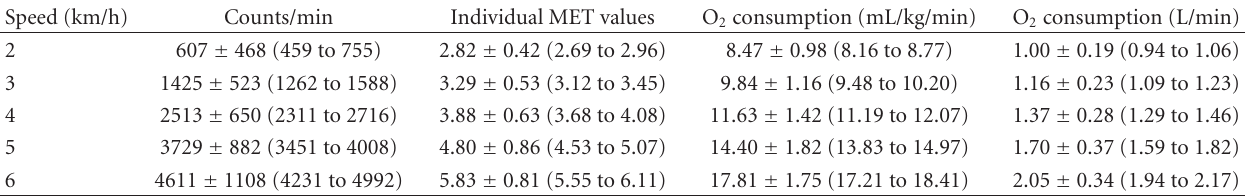
Table 2: Mean ± SD (95% CI) counts/min, individual MET values, and O 2 consumption at di ff erent treadmill speeds. All values are significantly di ff erent from the preceding values ( P < . 05) ( n = 41 at 2 and 5km/h; n = 35 at 6 km/h). Speed (km/h)